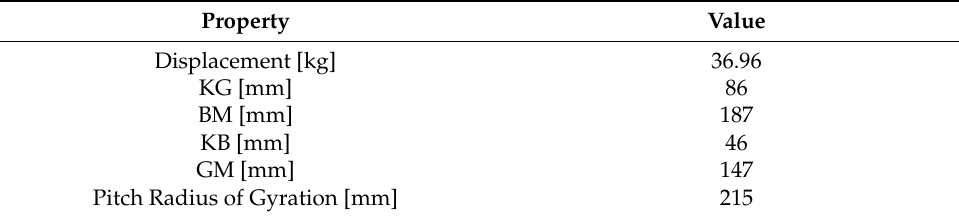
Table 1. Main properties of the floater.